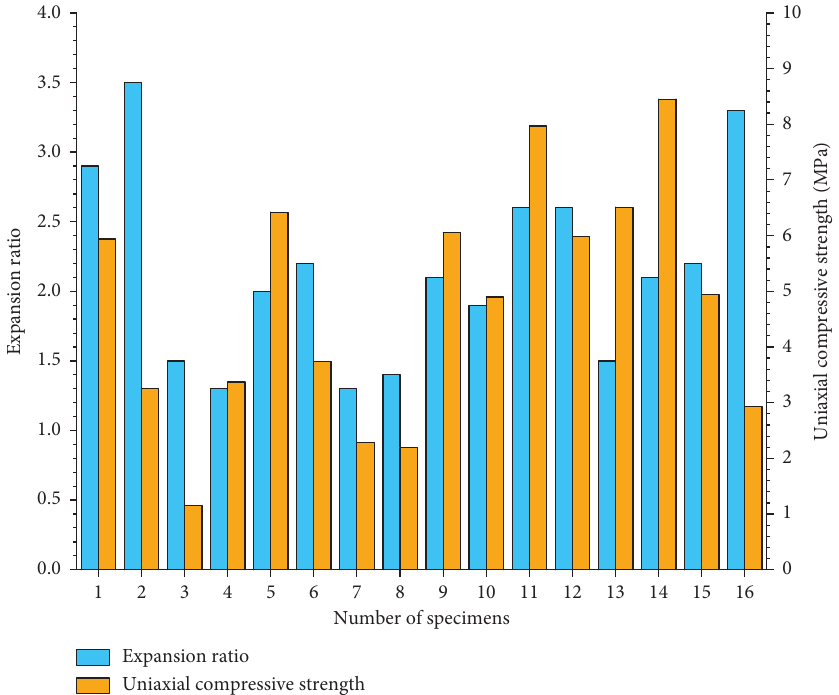
Figure 10: Relationship of expansion ratio with mechanical